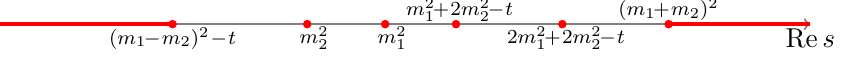
Figure 3 . The scattering amplitude on the real s axis in a theory with two massive states. We can draw integration contours analogous to C and C 0 from (cid:12)gure 2, providing that none of the poles overlap with the branch